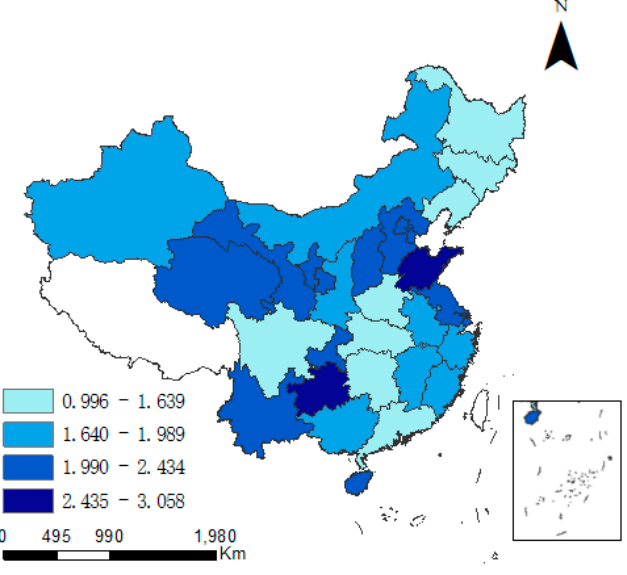
Figure 4. Industrial pollution emissions in 1997. Int. J. Environ. Res. Public Health 2018 , 15 , x